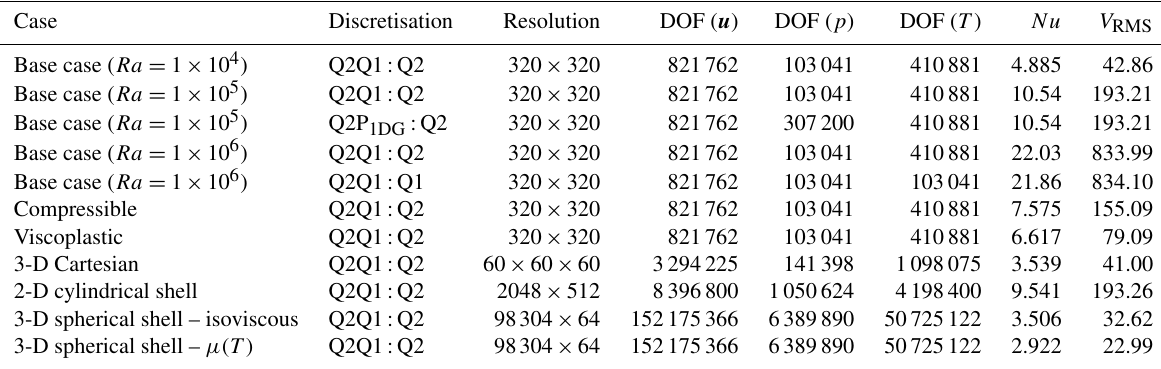
Table A1. Highest-resolution results from the benchmark cases analysed herein. DOF: degrees of freedom for velocity ( u ), pressure ( p ) and temperature ( T ). Nu : surface Nusselt